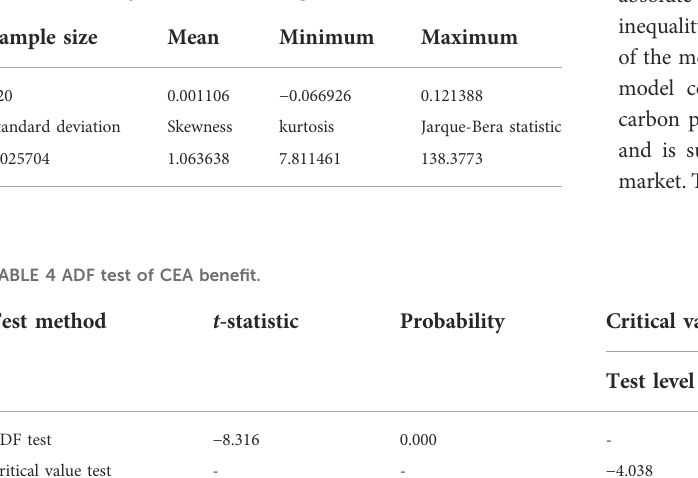
TABLE 3 Summary statistics of CEA logreturns.